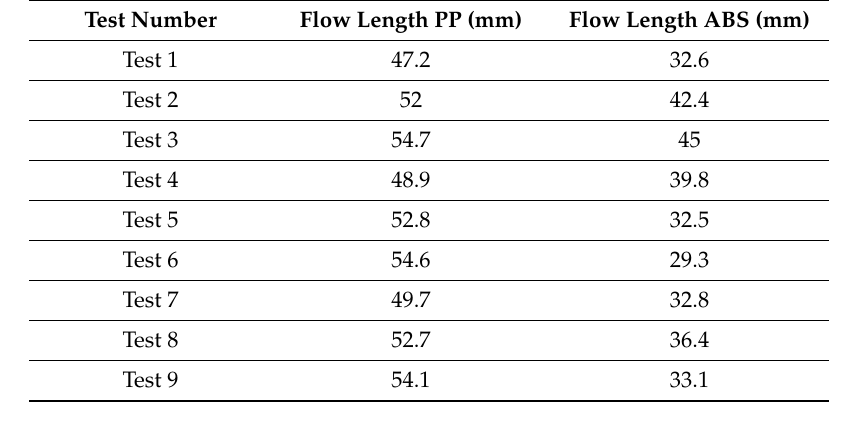
Table 5. Flow lengths for tests of PP and ABS [30].